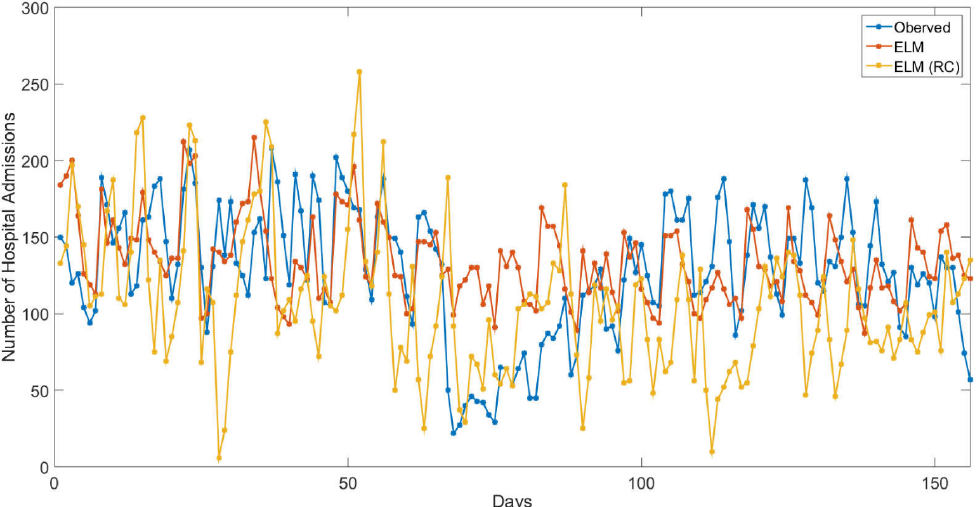
Figure 9. The number of hospital admissions by day of the test set for ELM lag 2-São Paulo (observed versus estimated